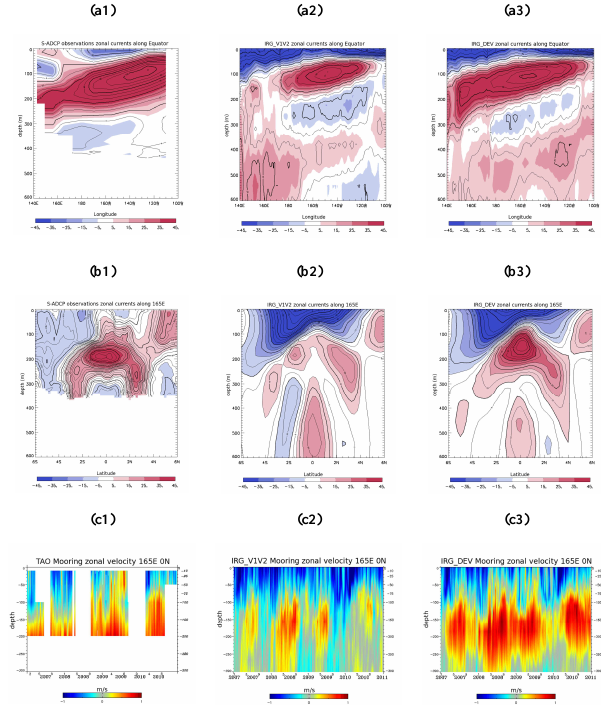
Fig. 24. Zonal velocity (cm s -1 ) equatorial longitude-depth section ( a1 , a2 , a3 ) and latitude-depth section at 165° E ( b1 , b2 , b3 ) in the Pacific Ocean. Zonal velocities over depth and time at the 165° E / 0° N TAO mooring for the 2007-2010 period ( c1 , c2 , c3 ). Zonal velocities come from IRG_V1V2 ( a2 , b2 , c2 ) and IRG_DEV ( a3 , b3 , c3 ) for the year 2010. Mean zonal sections of ADCP zonal currents come from Johnson et al. (2002) ( a1 and b1 ), and from the TAO ADCP measurements ( c1 ).